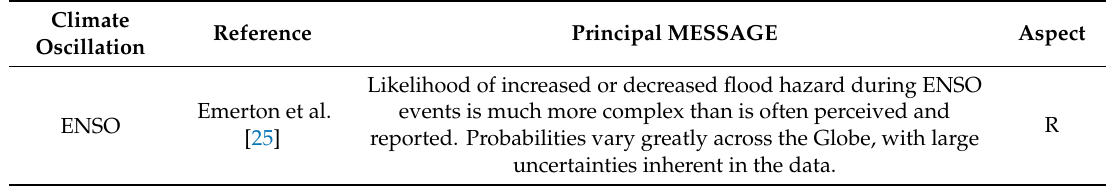
Table 2. Review of links between climate oscillations and floods, reported in global studies. Aspects